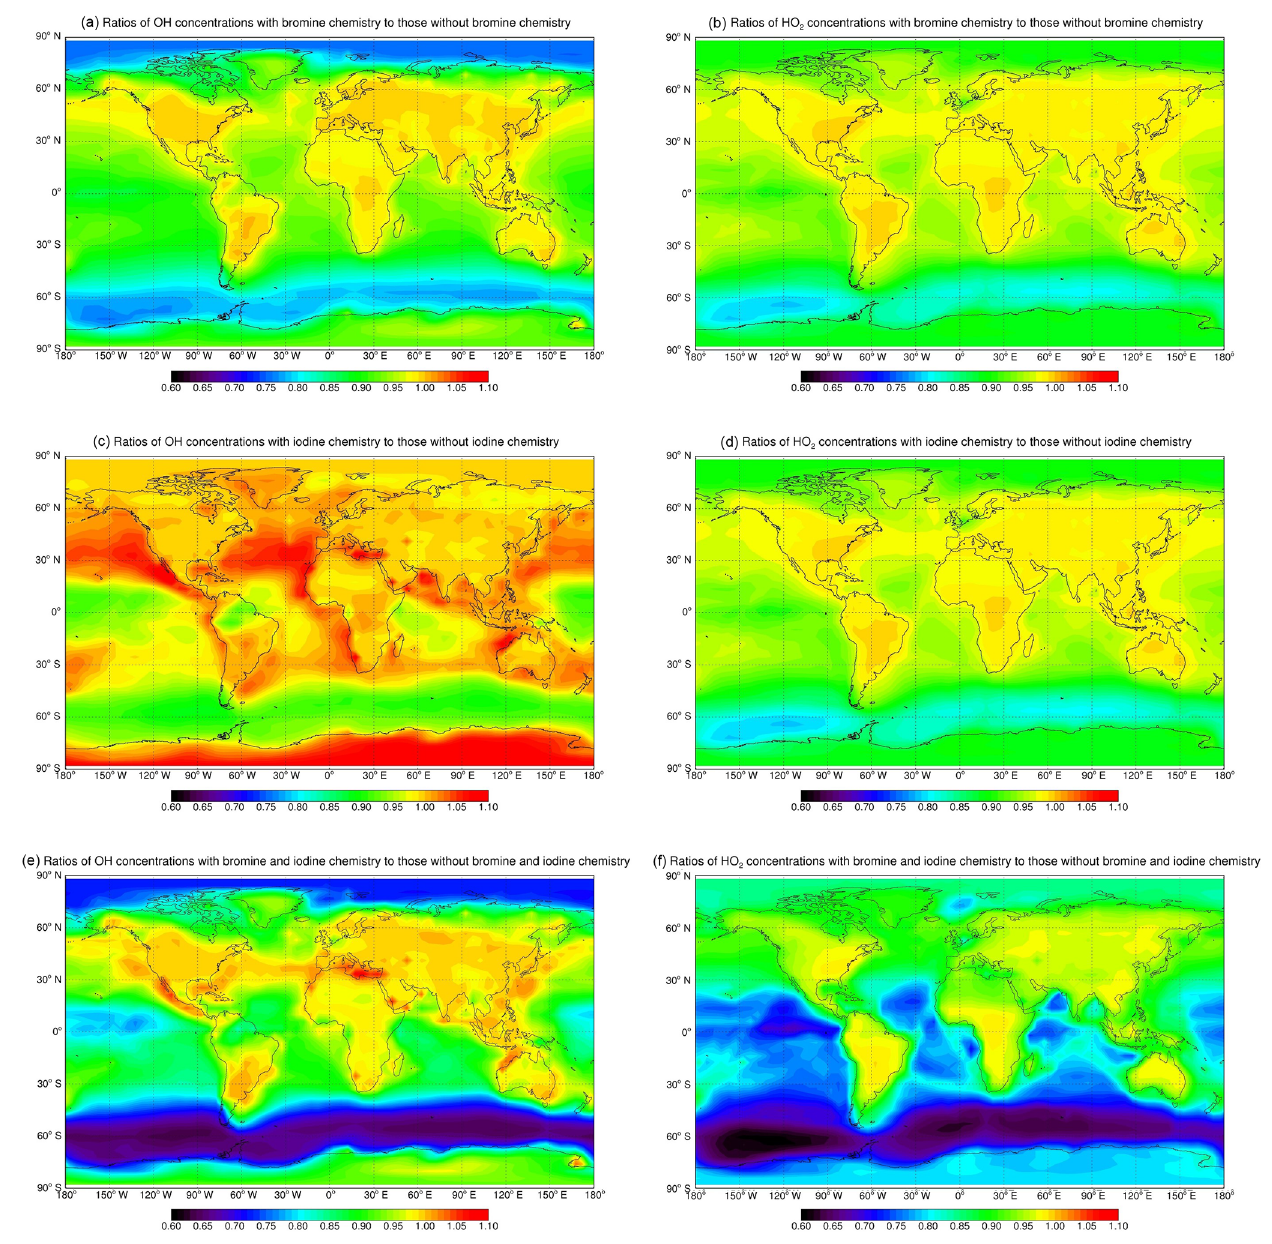
Figure 8. Percentage changes to annual surface layer concentrations of OH (a,c,e) and HO 2 (b,d,f) in GEOS-Chem on inclusion of bromine chemistry (a,b) , iodine chemistry (c,d) and bromine and iodine chemistry combined (e,f)